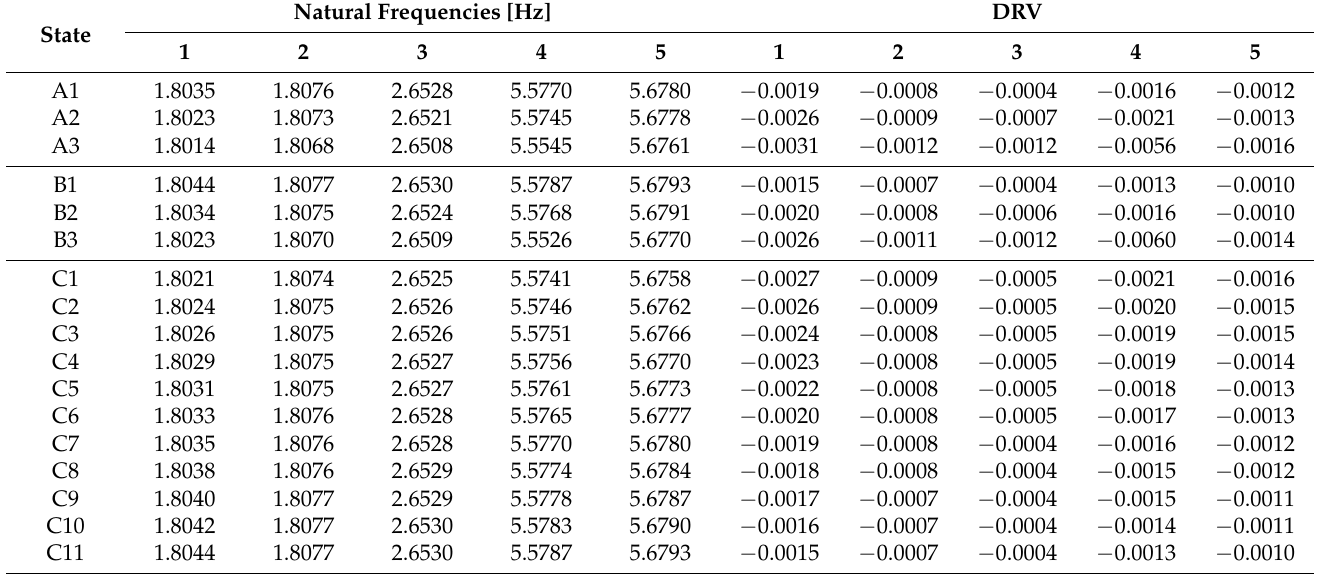
Table 6. Natural frequencies and damage reflection vector (DRV) of test cases A, B, and